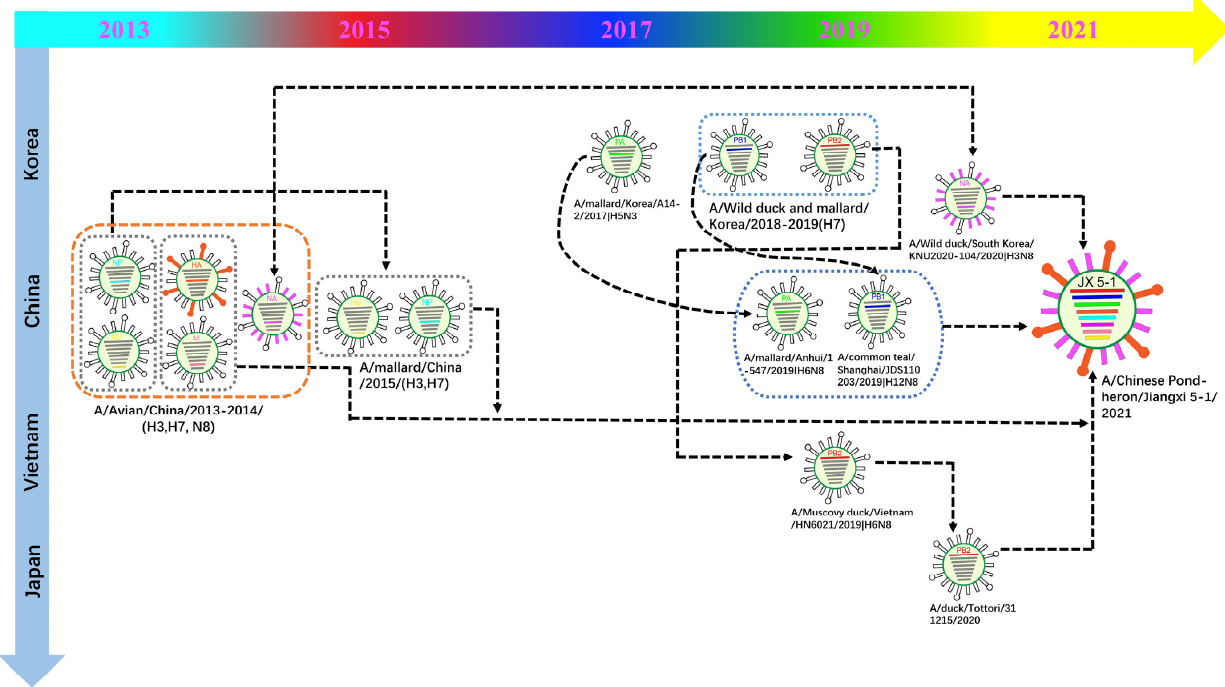
Viruses 2023 , 15 , x FOR PEER REVIEW Figure 2. Locations of the putative origin of genomic compositions of the H3N8 (JX 5-1).